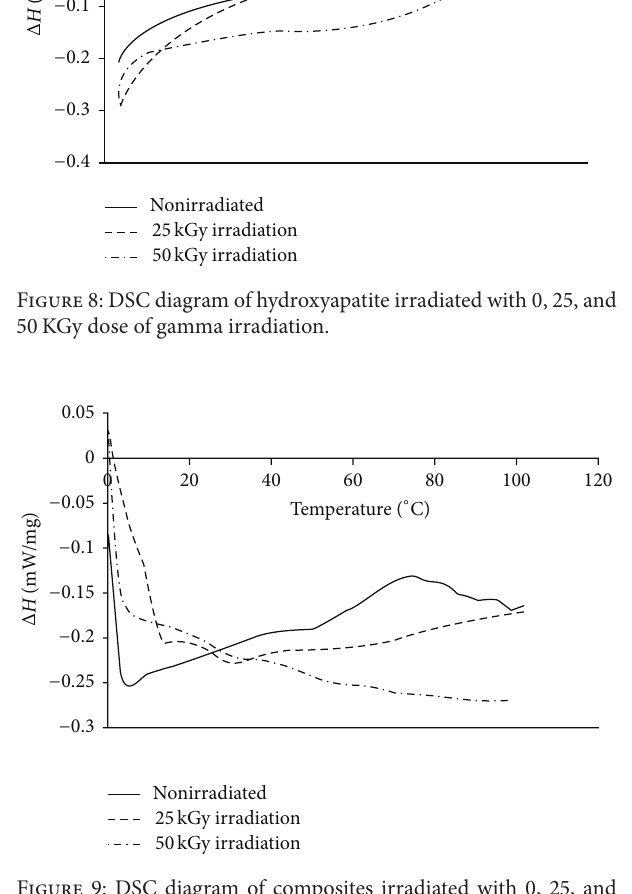
Figure 9: DSC diagram of composites irradiated with 0, 25, and 50 KGy dose of gamma